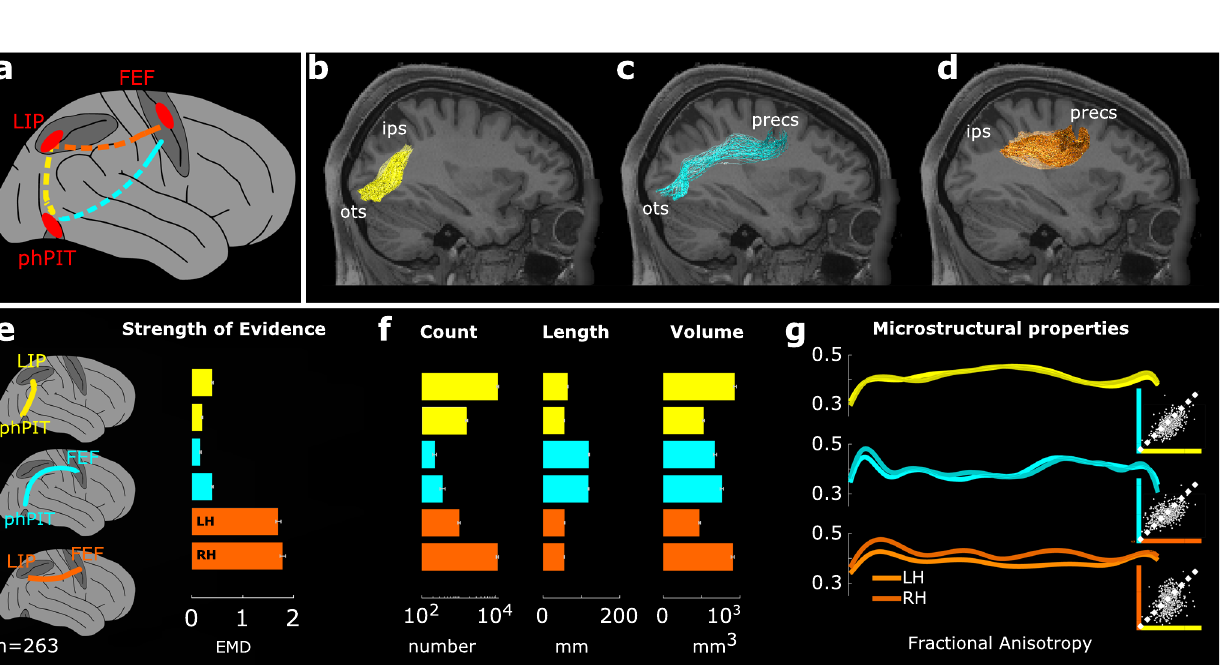
Fig. 6 Human dorso-ventral attentional connection identi fi ed using tractography. a Schematic connections; phPIT – LIP: yellow trace; phPIT – FEF: cyan trace; LIP – FEF: orange trace. b – d Sagittal-view of phPIT-to-LIP, phPIT-to-FEF, and LIP-to-FEF connections overlaid on T1 image for subject 101006. Conventions as in Fig. 1. e The bar plot shows the mean earth mover ’ s distance (EMD; see also Methods) in support of the existence of the tracts; lower bars for each tract represent the average across the right hemisphere, upper bars across the left. f Bar plots show the average streamline number, tract length (mm), tract volume (mm 3 ) for functional tracts of 263 subjects; lower bars for each tract represent the average across the right hemisphere, upper bars across the left. g Microstructural properties of functional tracts as measured by fractional anisotropy (FA; see Methods). Each line represents the FA value averaged across subjects and calculated along the tract. Insets show direct comparison of individual subject FA between phPIT – LIP and phPIT – FEF connections (top), LIP – FEF and phPIT – FEF connections (middle), phPIT – LIP and LIP – FEF connections (bottom). Data are expressed as mean across 263 subjects, and separately for the two hemispheres; gray points represent the values for each individual subject. ips intra-parietal sulcus, ots occipito- temporal sulcus, sts superior temporal sulcus, preces pre-central sulcus, FEF frontal eye fi eld, LIP lateral intra parietal area, phPIT putative human posterior infero-temporal area, LH left hemisphere, RH right hemisphere. Source data are provided as a Source Data fi